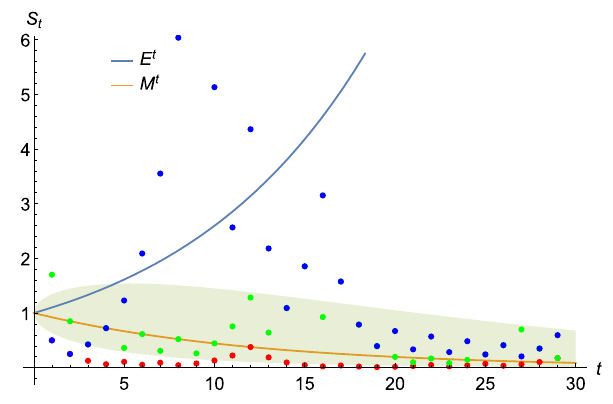
Fig. 1 Temporal variation of size S t in a stochastic multiplicative growth model. The exponential growths by the mean E and the median M are contrasted. Dots indicate three realizations of the stochastic process. The values within the shaded area account for 68% of the data set (either of the two growth rates l 1 = 0.5 and l 1.7 occurs with a 50% 2 =